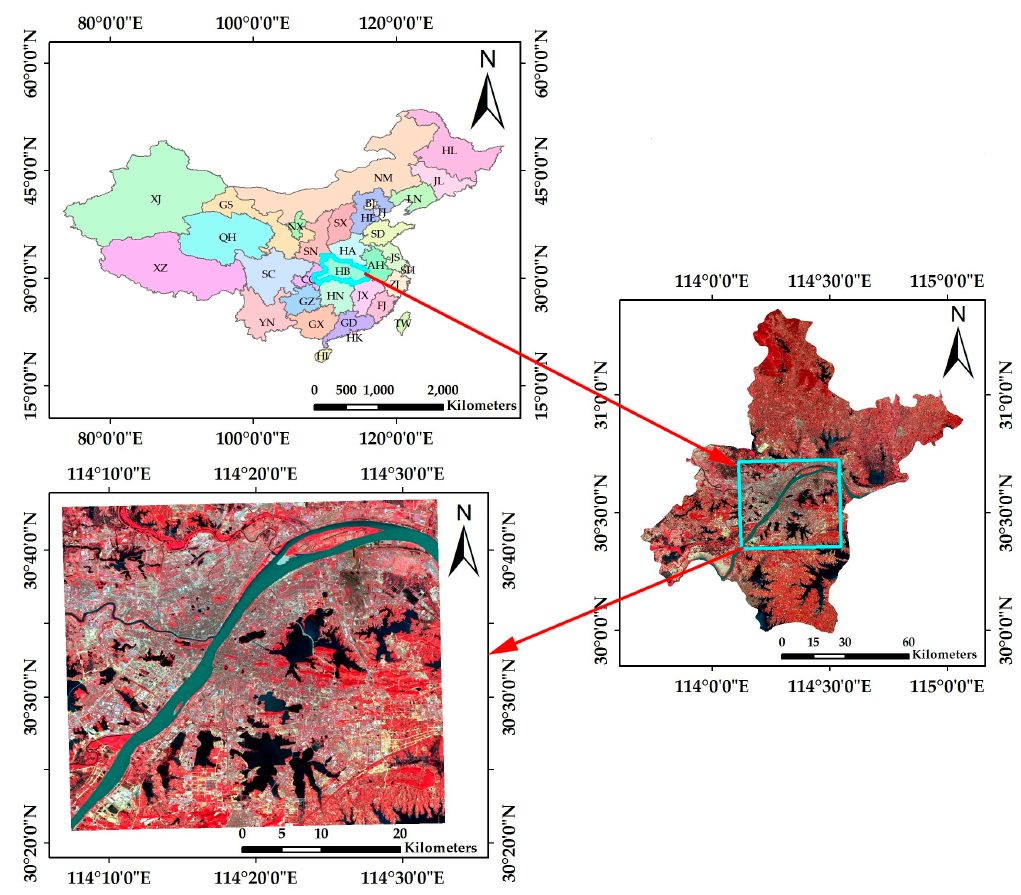
Figure 1. The geographic location of the study area.